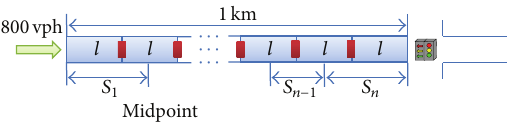
Figure 1: Partitioned arterial street with traffic